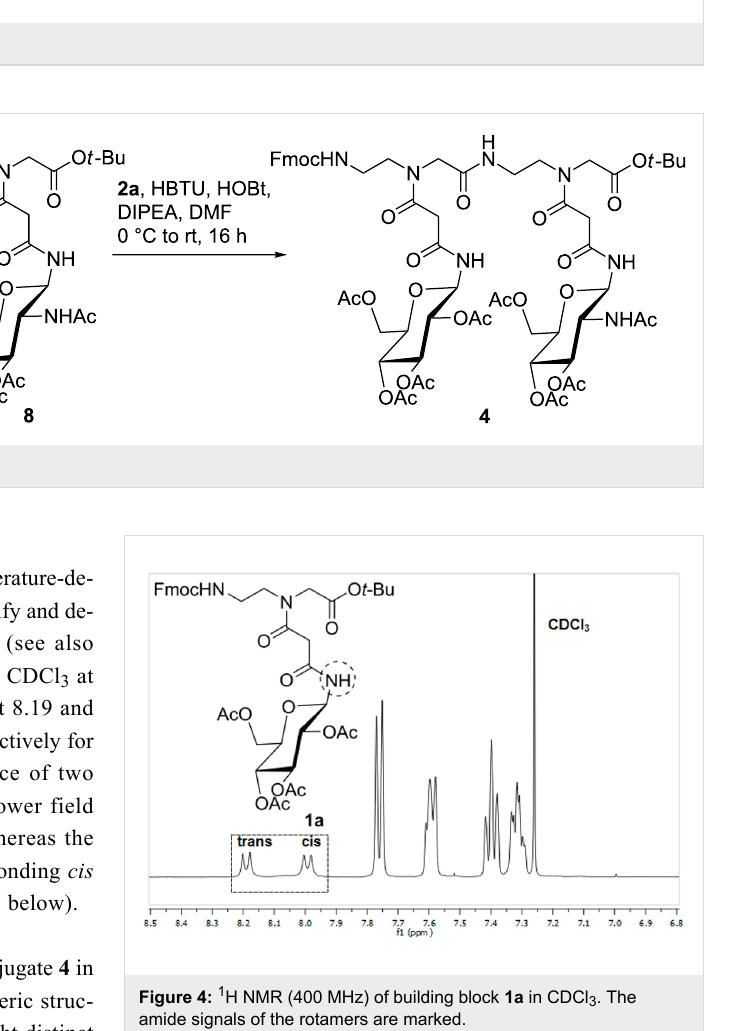
DMF- d 7 , and chlorobenzene- d 5 as well (Figure 7). In DMSO- d